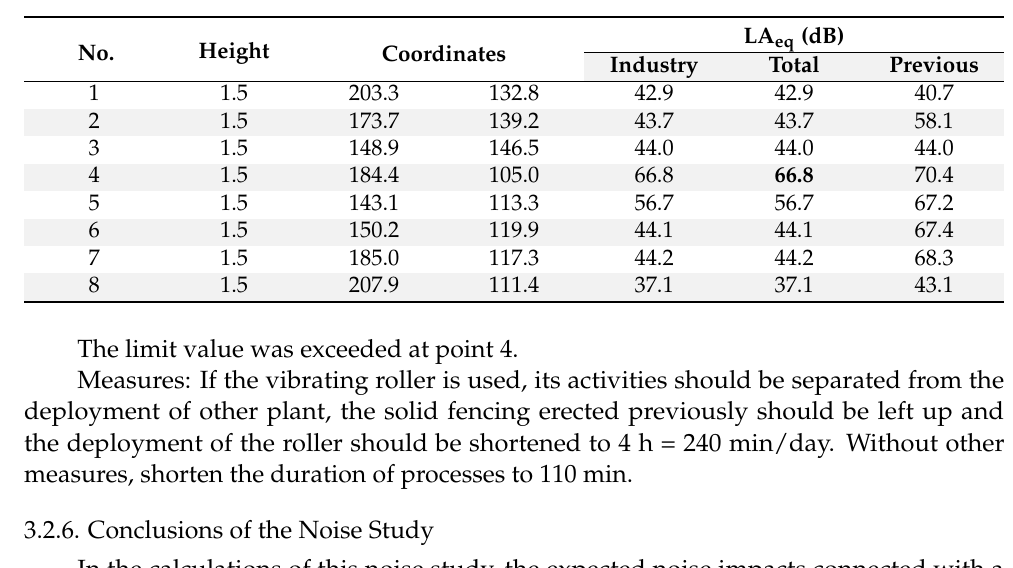
Figure 22. Colour map of isophone bands after considering acoustically significant elements for final landscaping with construction site fencing and a solid gate in the investigated area. Table 25. Table of points from the calculation of measured points for final landscaping with construction site fencing and a solid gate in the investigated area.